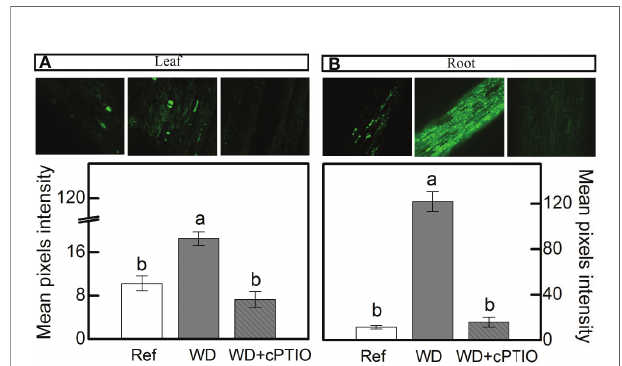
FIGURE 8 | Confocal microscopy images showing intracellular NO synthesis in leaves (A) and roots (B) of sugarcane plants supplied with only NO 3 − (100:0 NO 3 − :NH 4+ ) and maintained well-hydrated (reference, white bars), subjected to water de fi cit (WD, gray bars) and subjected to water de fi cit and sprayed with cPTIO (WD+cPTIO, gray striped bars). Mean pixel intensities are also shown. Bars represent the mean value of four biological replicates ± se. Different letters indicate statistical difference among treatments (BF 10 > 3 for leaf; BF 10 > 20 for root).